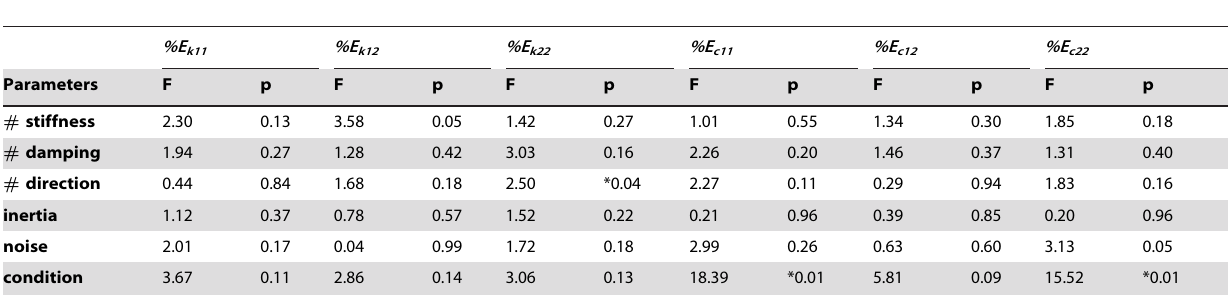
Table 6. Repeated measures ANOVA for the percentage RMS error using spectrogram technique among different inertial methods with directions of perturbation, stiffness and damping time-profiles as random factors along the interval 2.5–5 s.